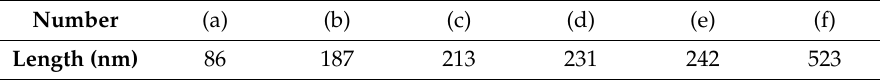
Table 5. Side lengths of the precipitated phase under different aging